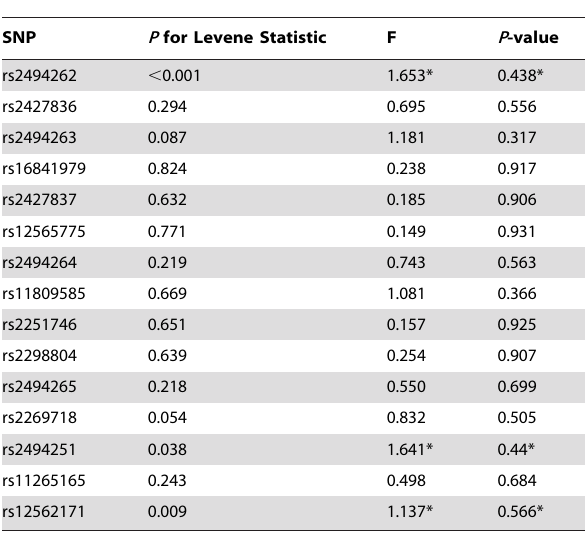
Table 3. Association between FCER1A SNPs and IgE levels.